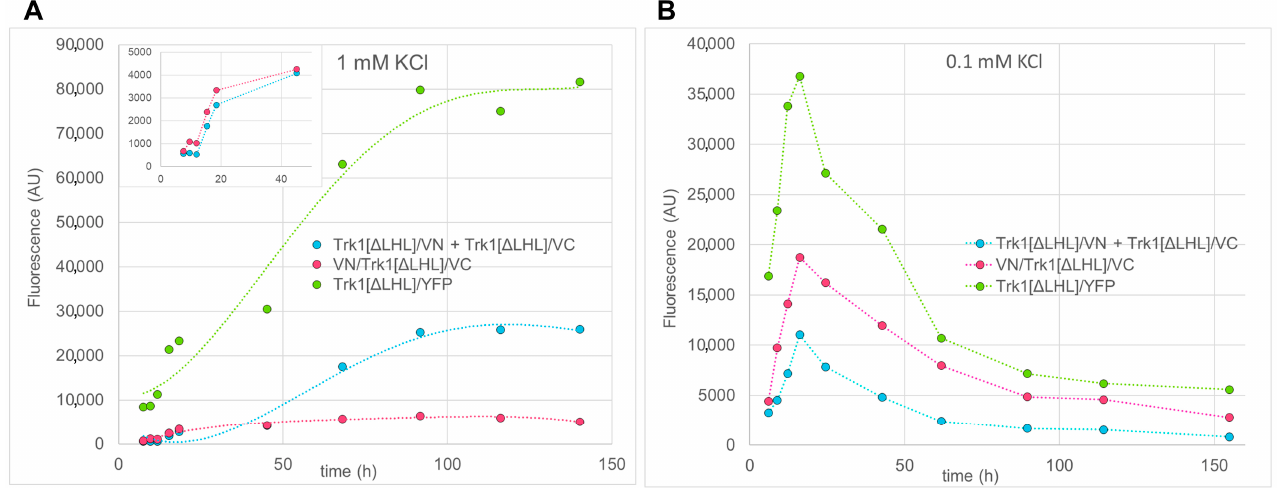
Figure 8. Time course of BiFC fluorescence for cells possessing Trk1 fusions with full or combinations of partial fluorescent proteins. ( A ) Cells grown in medium containing 1 mM KCl. For better visibility, exponential and early stationary phases of Trk1[ Δ LHL]/VN plus Trk1[ Δ LHL]/VC cells and VN/Trk1[ Δ LHL]/VC cells are shown magnified in the insert. Dashed lines in the main panel: (phenomenological) fit of polynomials of 4th degree; inset: dashed straight lines connecting data points. ( B ) Cells grown in medium with 0.1 mM KCl. Data points are connected by straight dashed lines. Data shown are from single representative experiments.